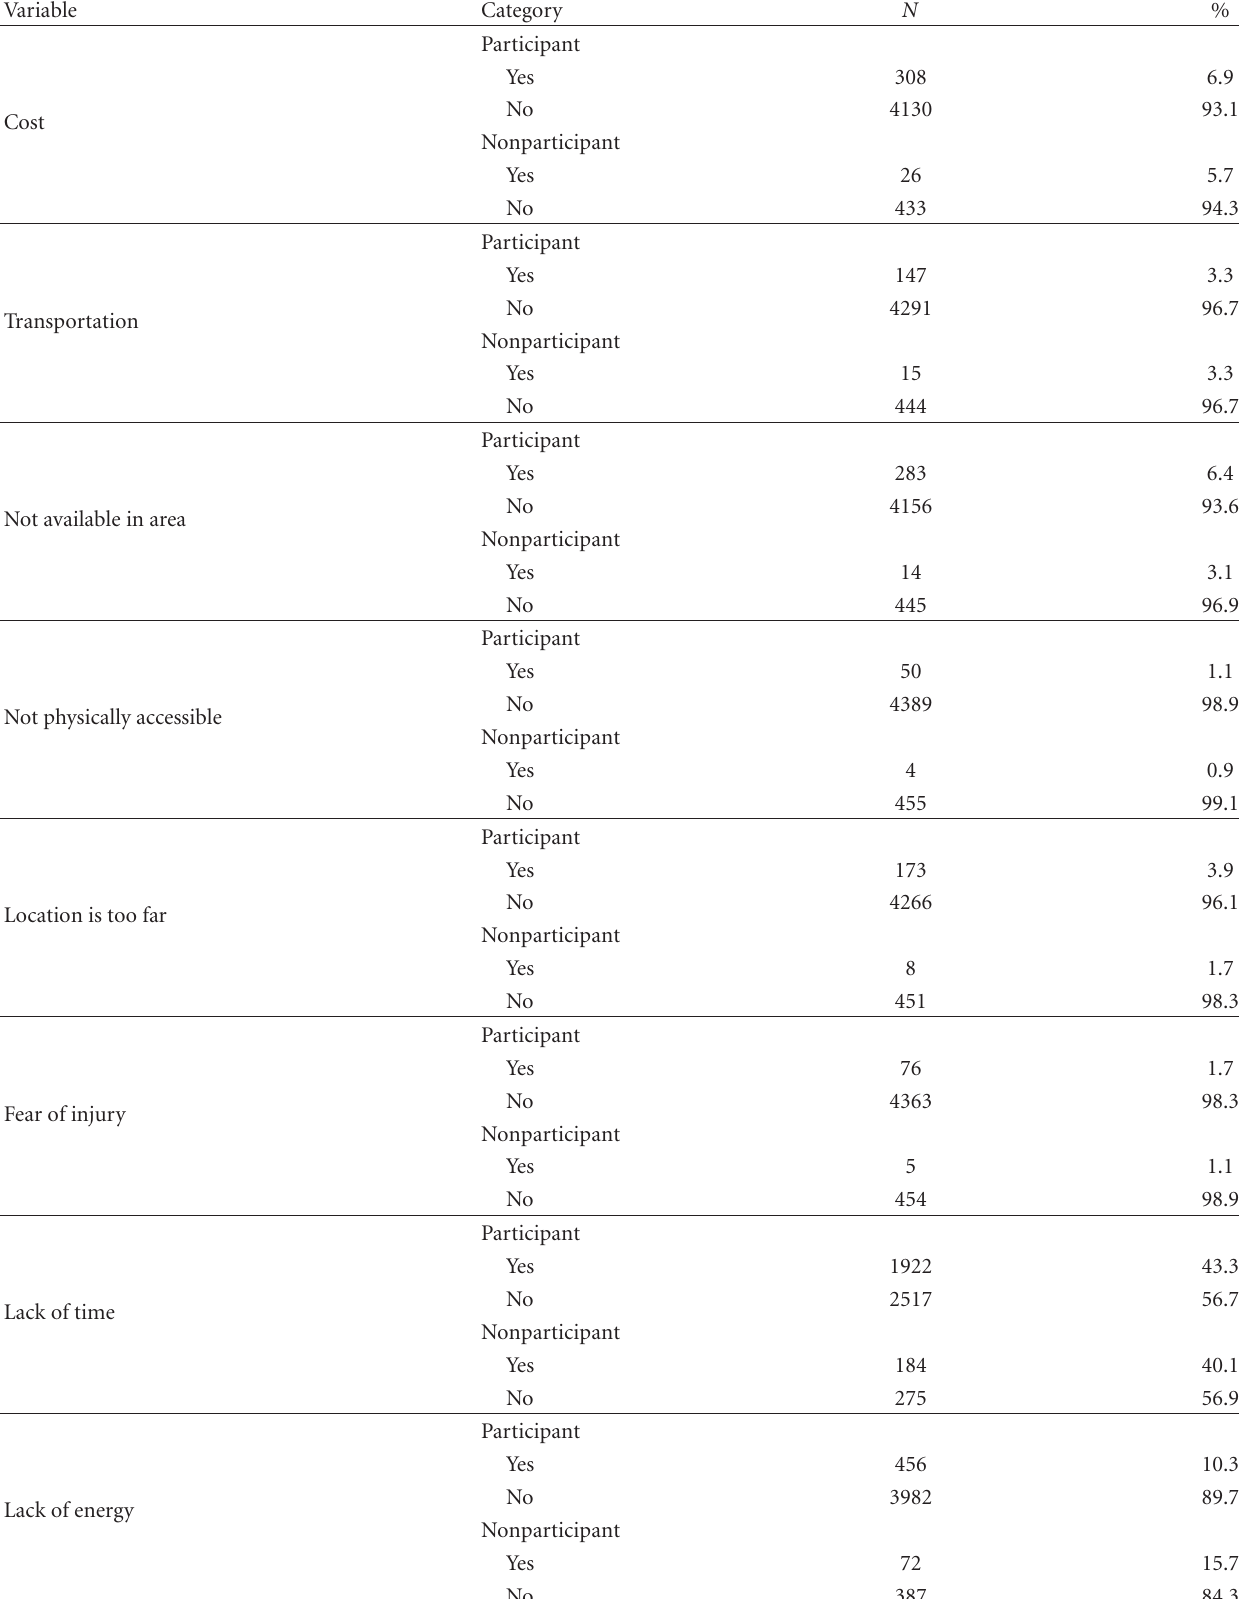
Table 2: Barriers by participation (weighted